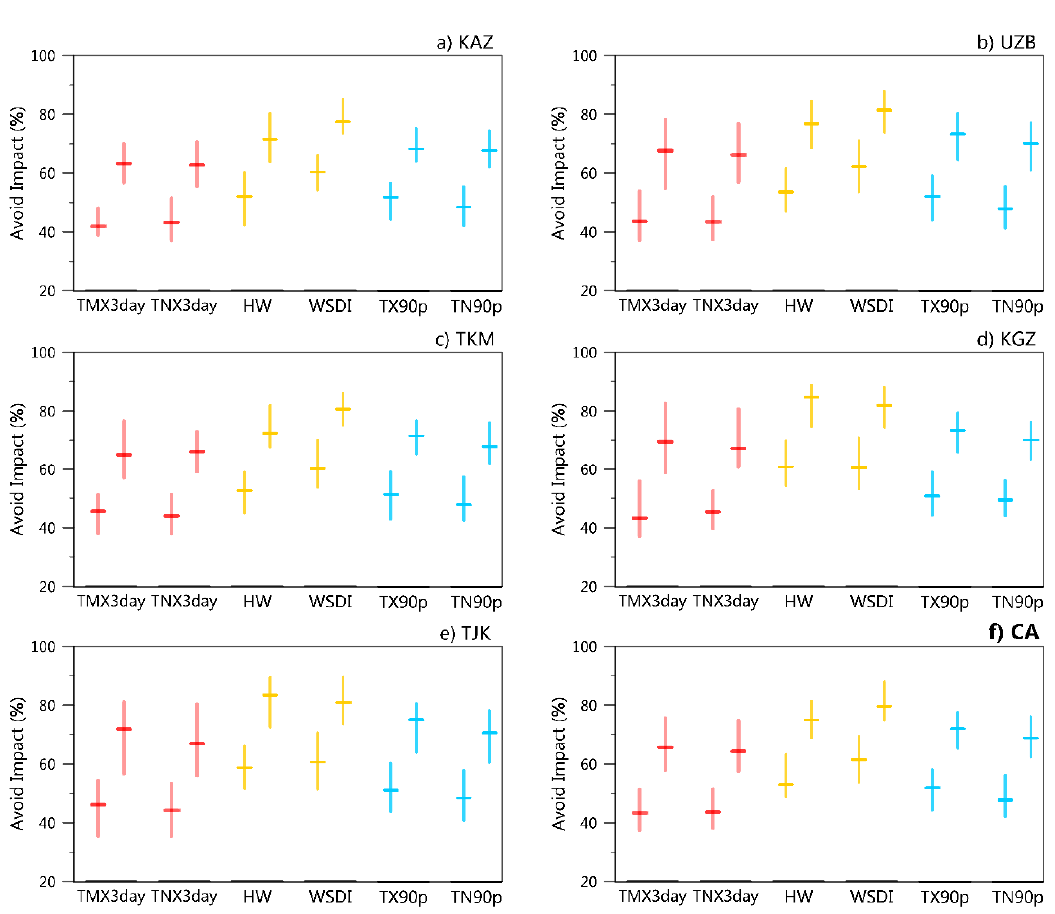
Figure 7. Changes of extreme high-temperature events avoided over Central Asia and its subregions in less warming scenarios (units: %). Population density weighted average extreme temperature indices is reduced in the low warming scenarios (left—2.0 °C compared to the INDC pledge, right—1.5 °C compare to INDC pledge). The red boxes represent the indices defined by intensity, the yellow boxes represent the indices defined by duration, and the blue boxes represent the indices defined by frequency. Central lines and bars denote multimodal medians and interquartile ranges, respectively. For the avoid impact based on regional average extreme temperature indices, refer to Figure S6.